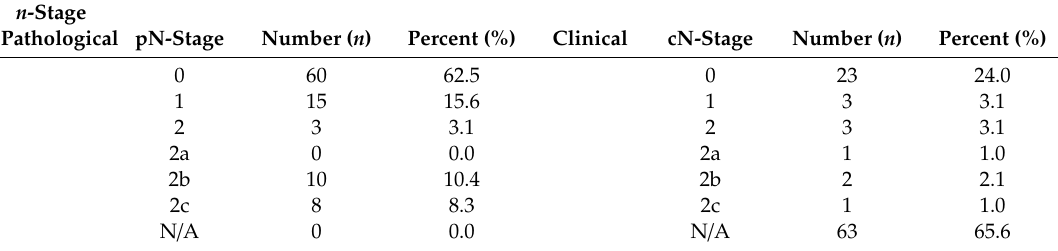
Table 3. Clinical and pathological classification of lymph node status.